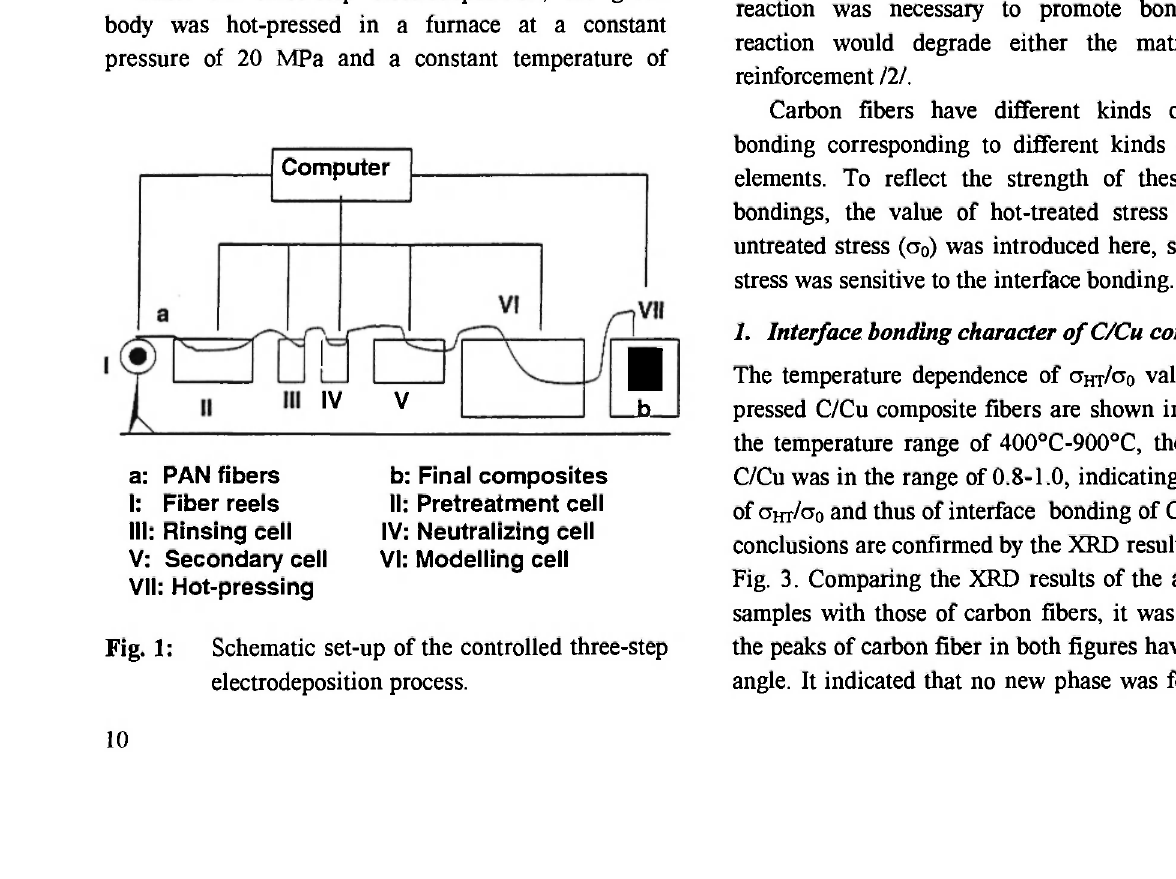
Fig. 1: Schematic set-up of the controlled three-step electrodeposition